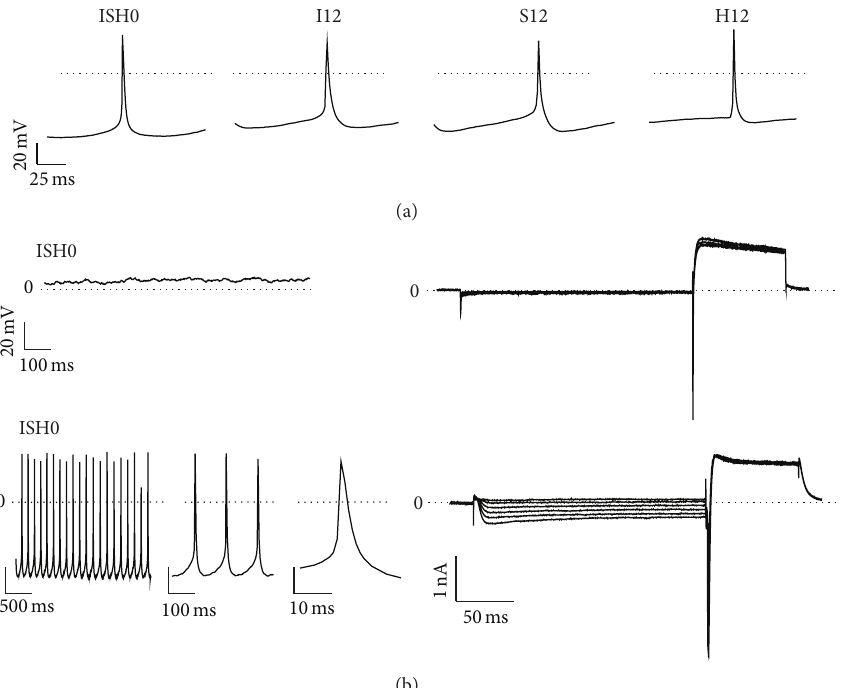
Figure 5: Electrophysiological analyses of MDSC-derived cells. (a) Representative action potential traces of initial cell population (ISH0) and after applying different cell culture conditions for 12 days (I12, S12, and H12) as measured by a whole-cell patch-clamp in current-clamp mode. (b) Voltage clamp measurements for recording of the pacemaker current 𝐼 𝑓 . The applied voltage protocol is shown above the traces, which are representative for cells which do not express (upper trace) and which express small (lower trace) 𝐼 𝑓